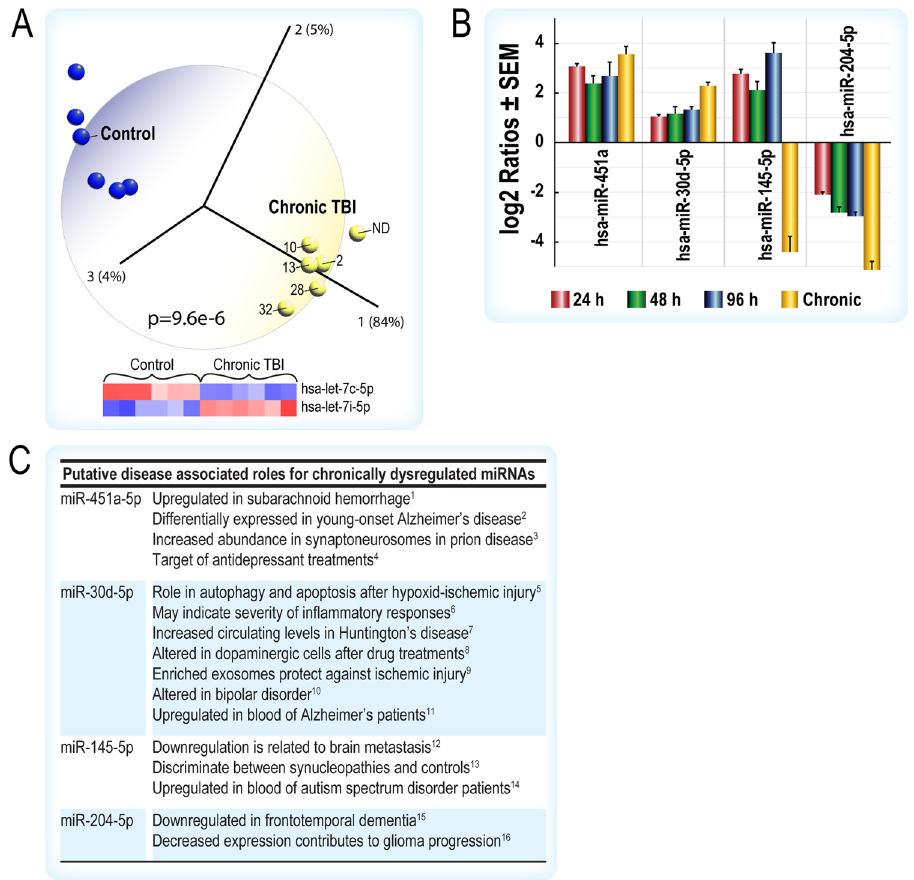
Data is displayed graphically as the log2 ratio ± SEM (y-axis) and significant miRNAs from the LRT and Wald tests in EdgeR and DESeq2 (x-axis). Red bars indicate 24 h, green 48 h, blue at 96 h post-TBI when compared to healthy controls. Orange bars indicate chronic TBI patient serum compared to healthy, age-matched controls. ( C ) miRNAs dysregulated in chronic TBI are associated with multiple brain disorders (citations in Supplemental references for Fig. 5C). Data were analyzed through the use of IPA (QIAGEN Inc.,